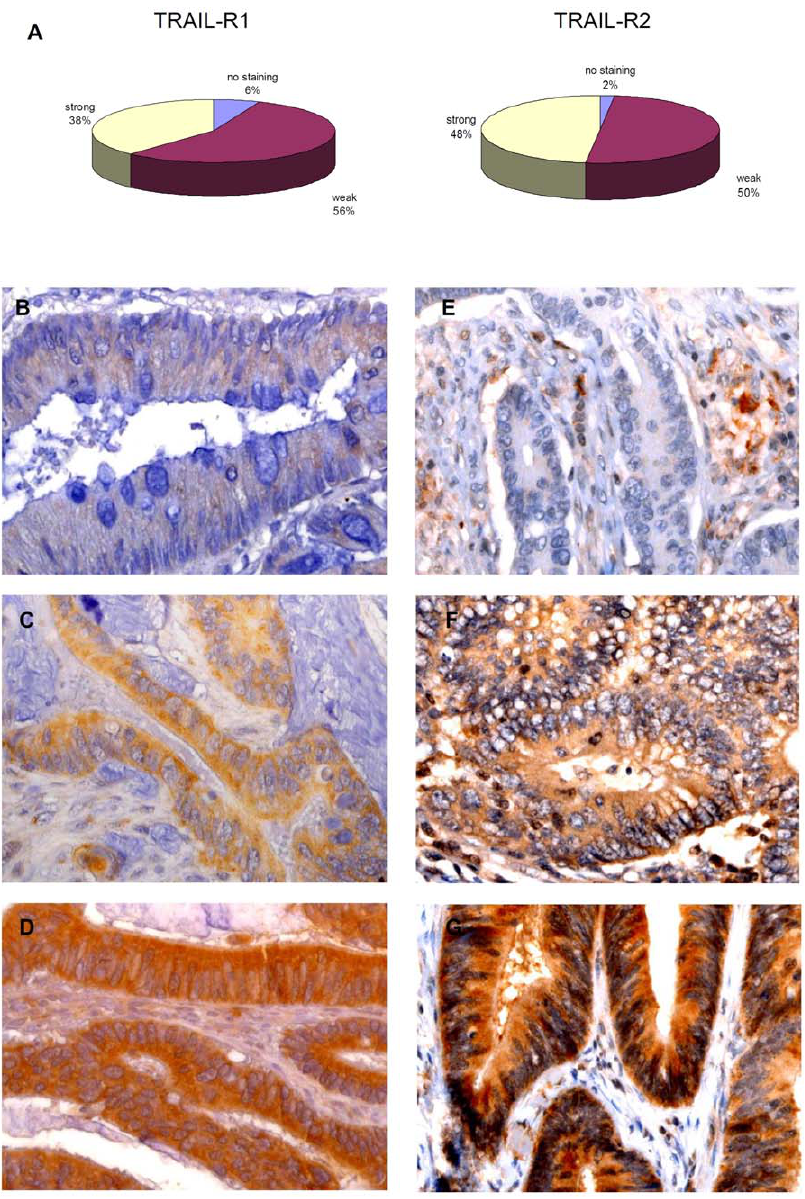
Figure 1. Semiquantitative evaluation of TRAIL-R1 and TRAIL-R2 staining in CRC cells. (A) Percentage of samples showing no staining, weak or strong immunoreactivity. (B–D): representative typical microscopic appearance of TRAIL-R1 staining (B: no staining. C: weak and D: strong staining). (D to F): staining of TRAIL-R2 (E: no staining. F: weak and G: strong staining). The present sections are representative of a grade 2 colonic cancer in stage II (T3N0M0) at the magnification of 630 6 .